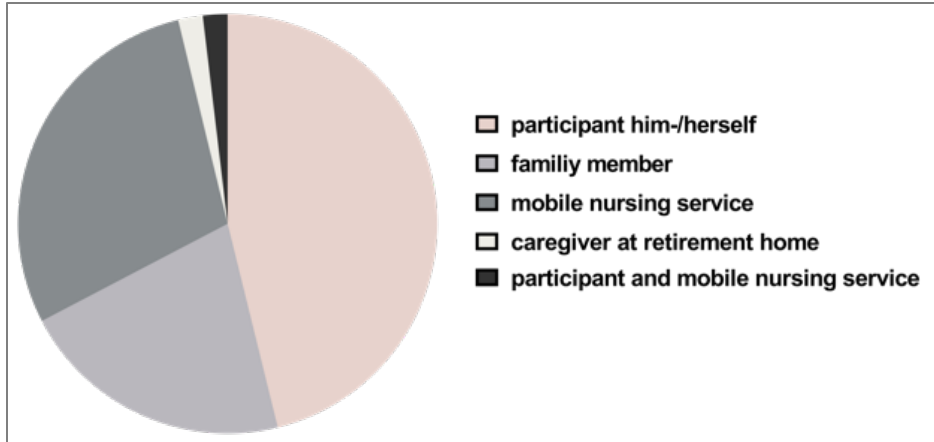
Figure 2. Responsibilities for medication management among the older participants.